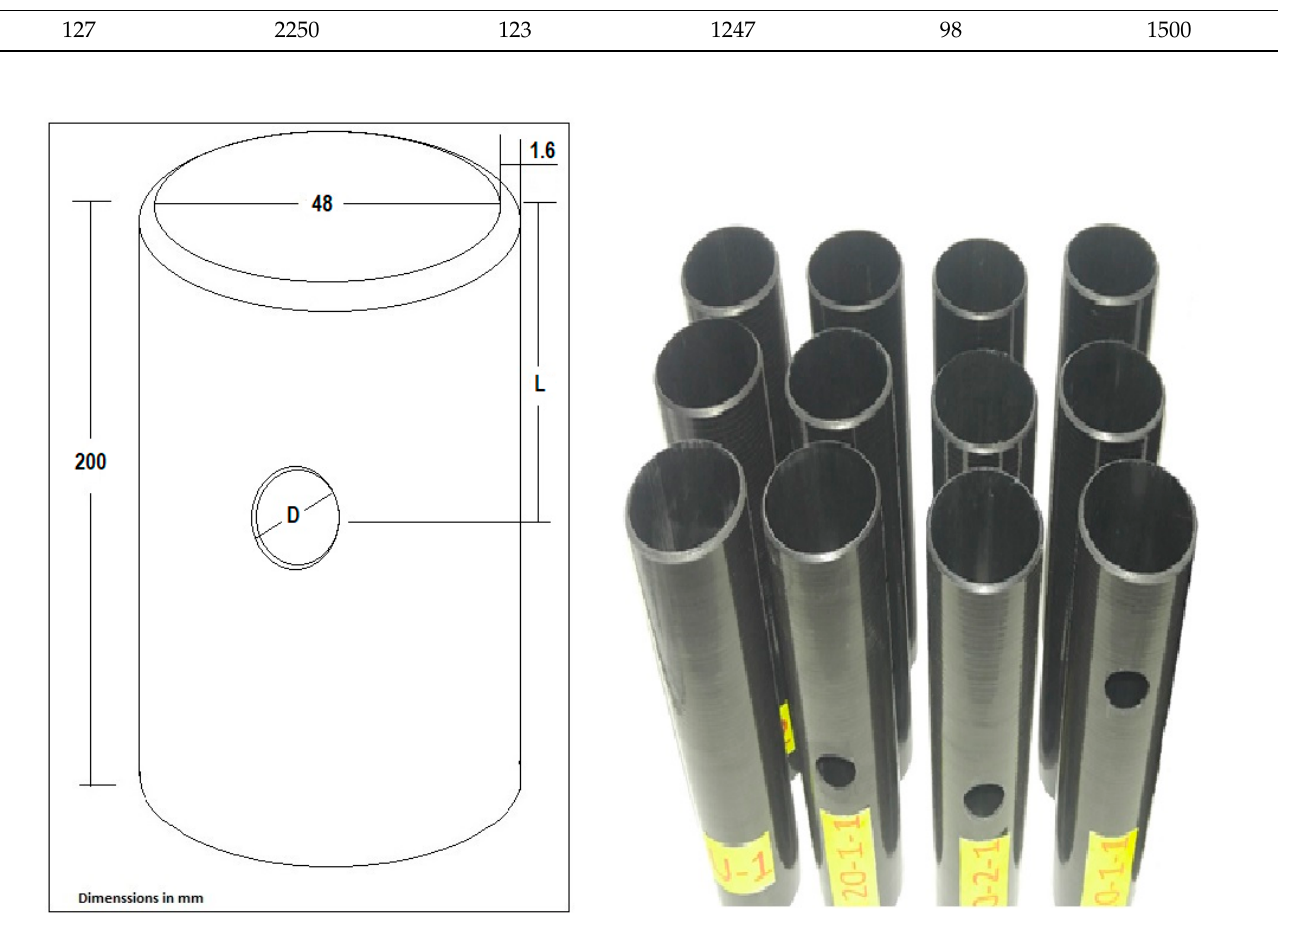
Figure 4. CFRP tube geometry and dimensions in mm. Table 2. Tube sample types and dimensions.